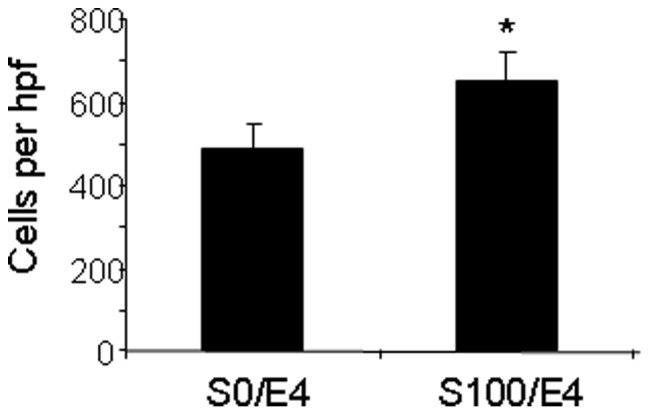
Exogenous SDF-1α augments adhesion of ECFCs to fibronectin.Adhesion of ECFCs to fibronectin after incubation with exogenous recombinant human SDF-1α and recombinant human E-selectin (4 µg/ml) (S100/E4) compared with control ECFCs incubated with E-selectin alone (S0/E4). (* p<0.05).